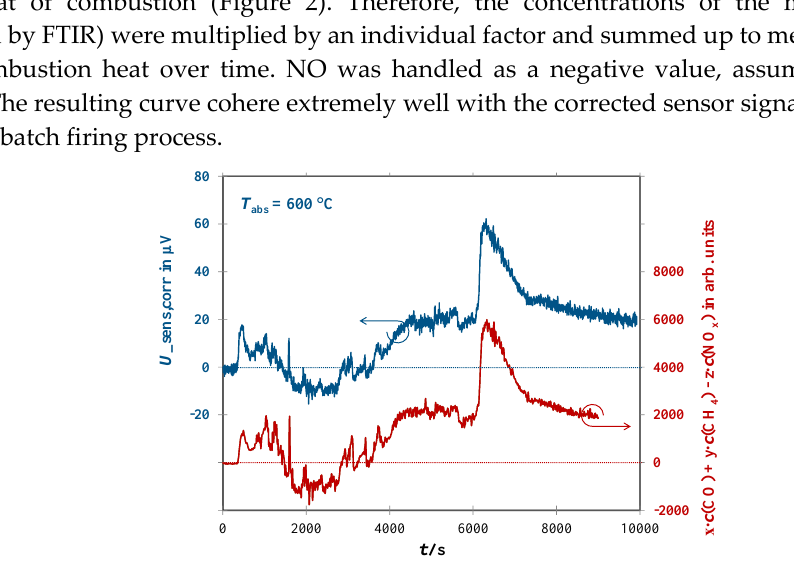
Figure 2. Comparison of the corrected sensor signal (details see text) and evaluated FTIR-data for a 2.5 h wood-log fueled firing